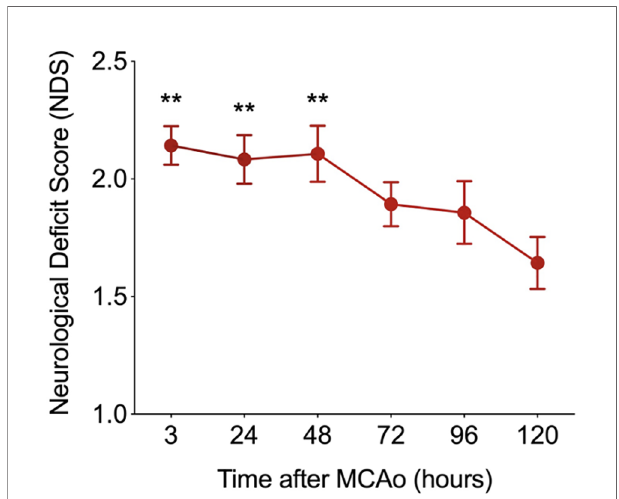
FIGURE 8 | The relationship between the neurological de fi cit score (NDS) and the time after MCAO (N=14). The improvement in NDS with time was signi fi cant (i.e. **p < 0.01) when comparing the fi nal time point recorded at t=120 hours to the fi rst three recorded time points after MCAO. A two- sample t-test was used to assess signi fi